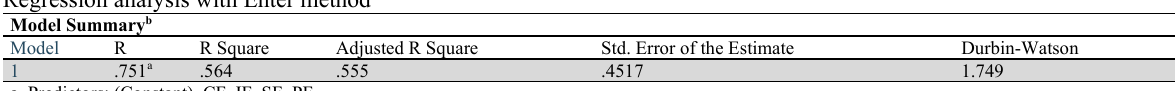
3.3 Regression analysis